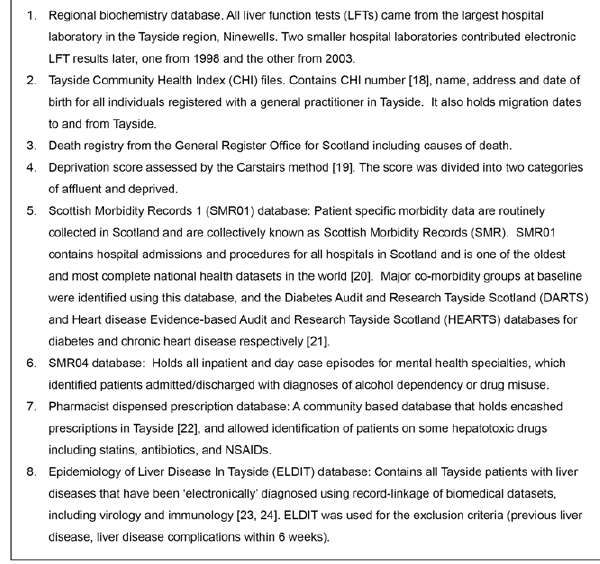
Figure 1. Databases record-linked to create the Tayside derivation